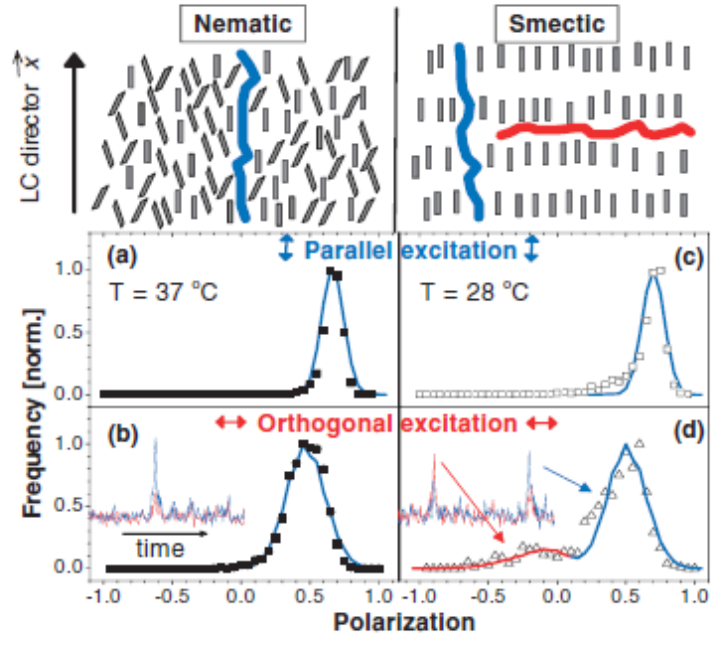
Figure 5. Orientations for solvation of MEH-PPV in a nematic (left) and smectic (right) LC. Top: Schematic solvation of long polymers (not scaled) is indicated by the blue and red chains. Bottom: Polarization ( P ) histograms measured with excitation polarized parallel ( a ), ( c ) and orthogonal ( b ), ( d ) to the director. The insets show a typical fluorescence burst from a single polymer molecule diffusing through the excitation volume. Positive P is consistent with parallel alignment to the director (blue chain). For orthogonal excitation in the smectic phase ( d ), the fluorescence transient reveals the presence of molecules with an opposite P . These molecules are orientated perpendicular to the director (red